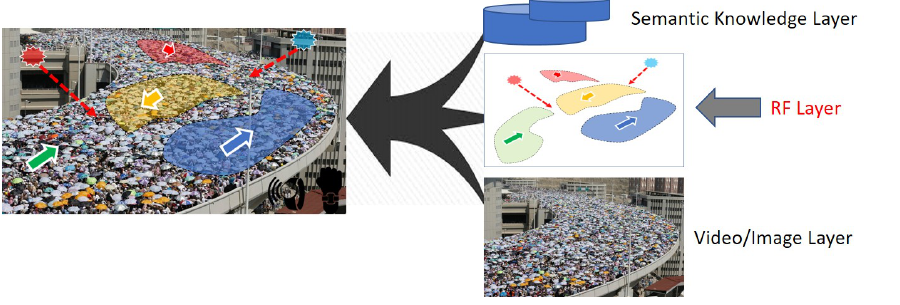
Figure 2. Intelligent crowd engineering